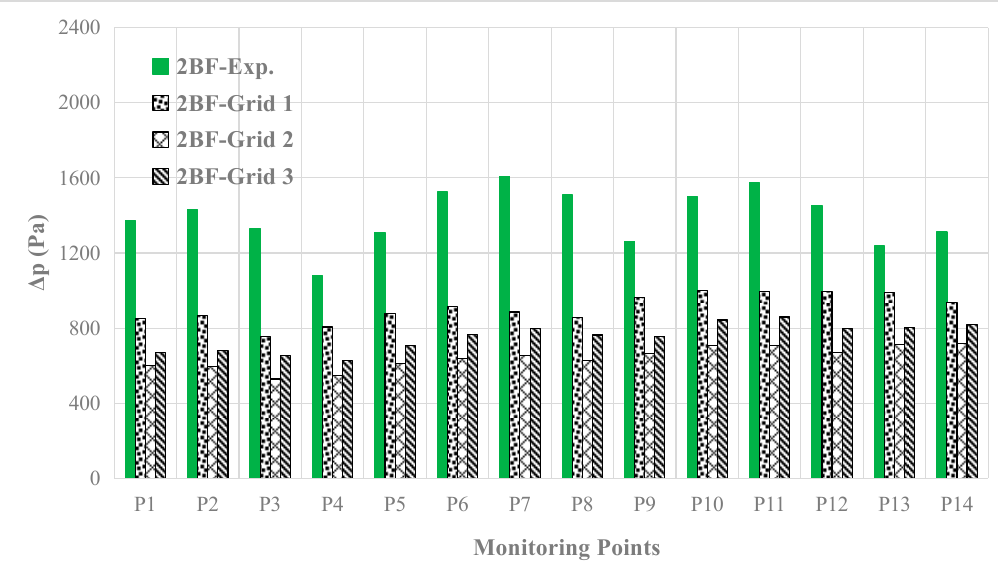
Figure 13. The 2BF component of hull pressure fluctuation predicted compared with the test data. J. Mar. Sci. Eng. 2019 , 7 , x FOR PEER REVIEW